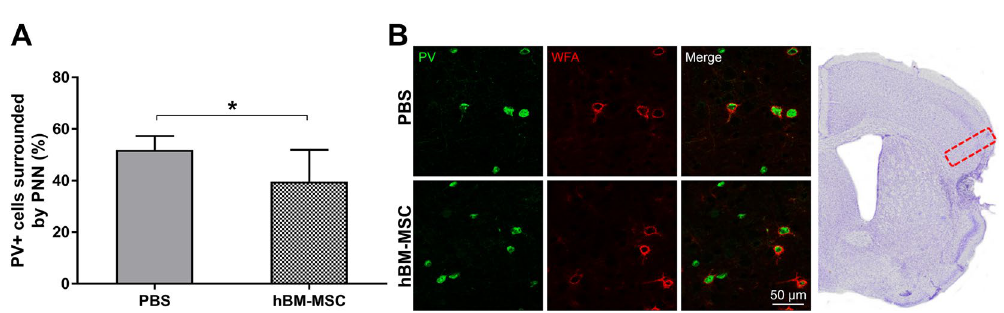
Figure 6. hBM-MSC induce a reduction of PV neurons surrounded by PNN. ( A ) Quantification of PV + neurons for PNN in perilesional cortex (red box in panel B) 5w post-injury shows lower PV + cells trapped in PNN after hBM-MSC administration. ( B ) Microphotographs show double immunofluorescence for PV + cells (green) and PNN (red) in ipsilateral cortex of tMCAo hBM-MSC and tMCAo PBS mice. Data are mean + SD, n = 6–10, unpaired t-test. * p < 0.05. Bar = 50 µ